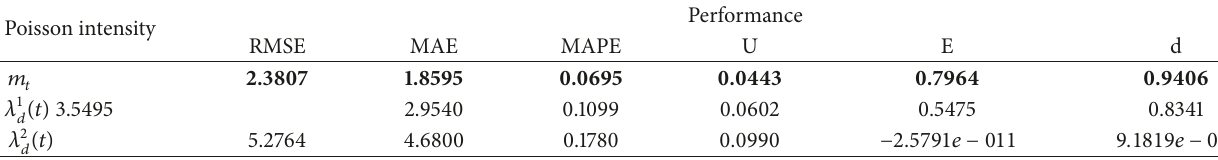
Table 2: Summary of the statistical tests for the Poisson intensity.